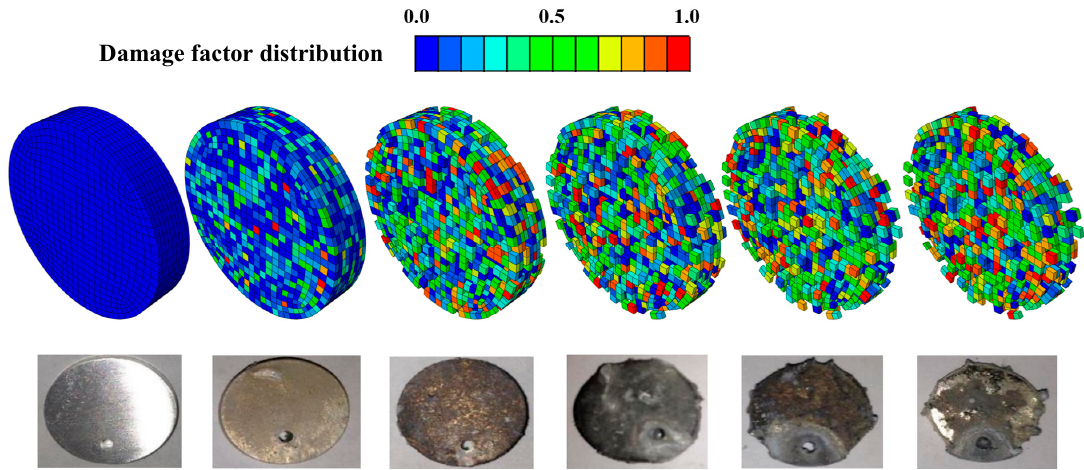
Figure 8. FE experimental results for immersion testing of Mg–1.2Zn–0.5Ca. The color code represents the value of the damage parameter d ranging from 0 to 1.